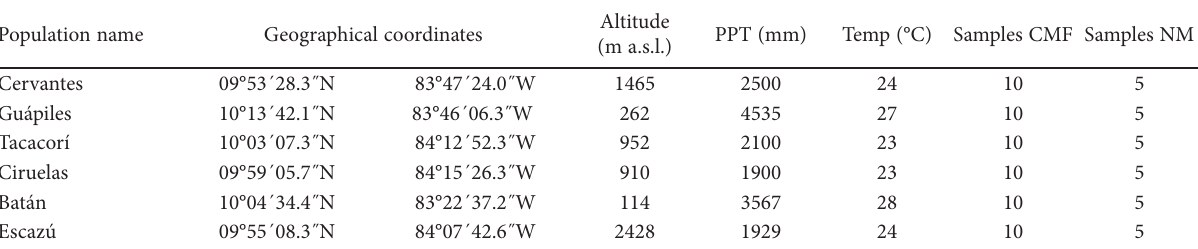
Table 2. Collection sites of “Costa Rican Guava” used to determine genome size and chromosomal number. PPT : mean annual precipitation (mm); Samples CMF : number of seedlings used for flow cytometry; Samples NM : number of samples used to determine chromosomes